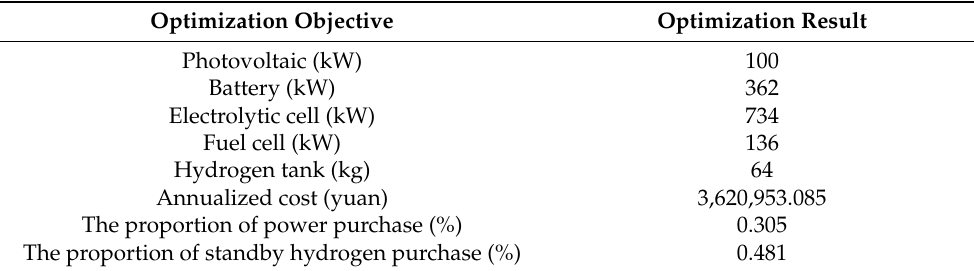
Table 2. Optimization